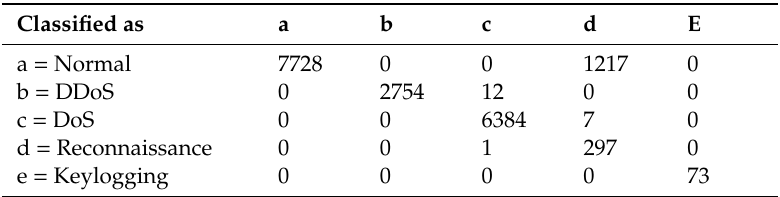
Table 8. Confusion Matrix results of using C5 classifier.